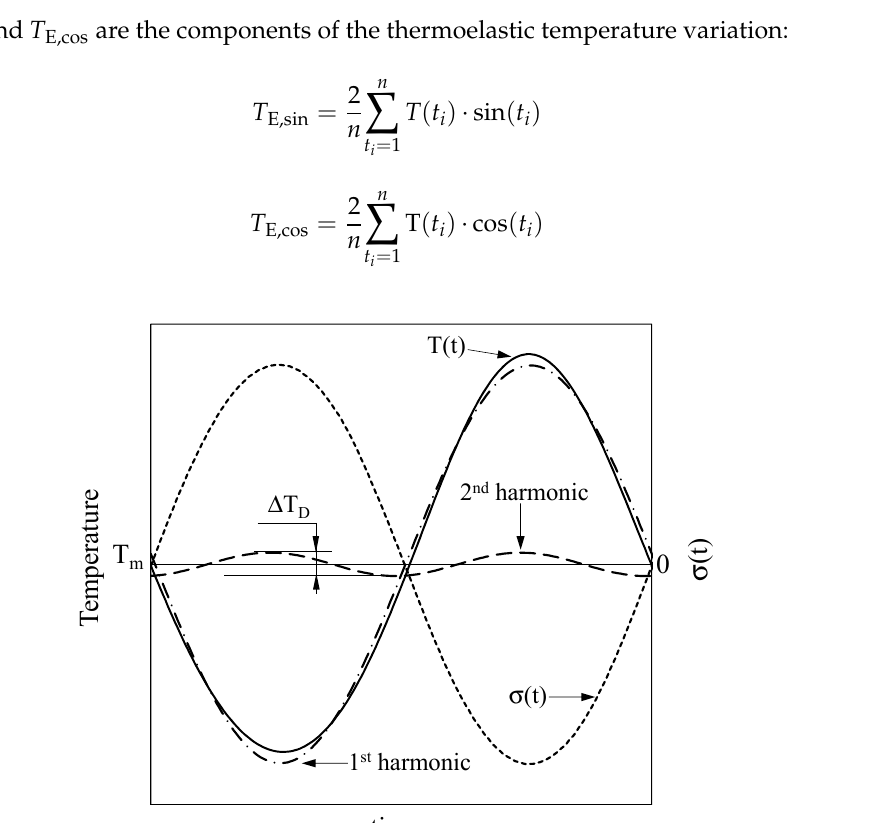
Figure 6. First and second harmonic of the temperature signal measured during a fatigue test.